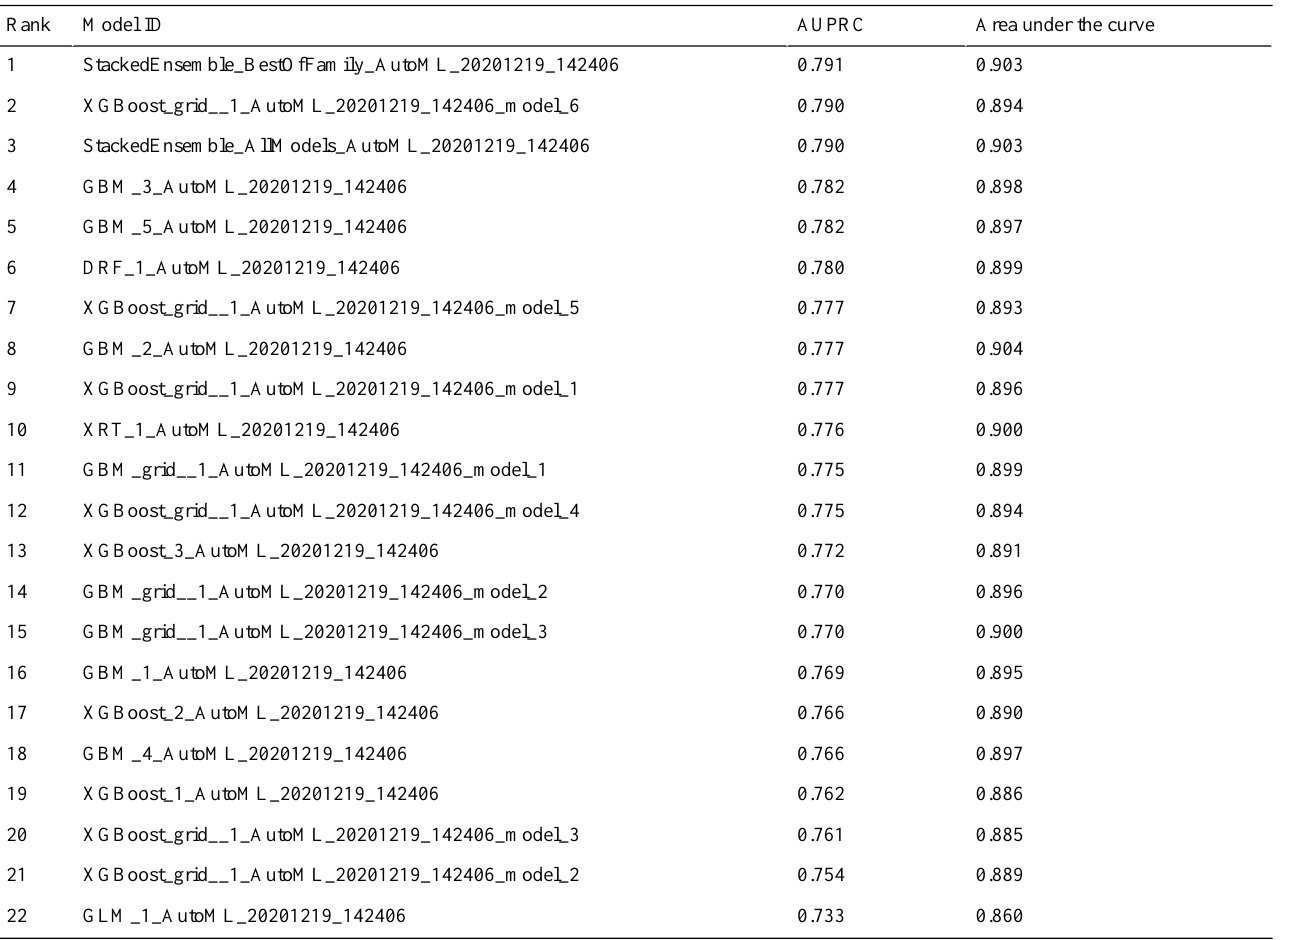
Table 3. Output of the automated machine learning models that used 10 variables. Model ranks are ordered according to AUPRCs a .